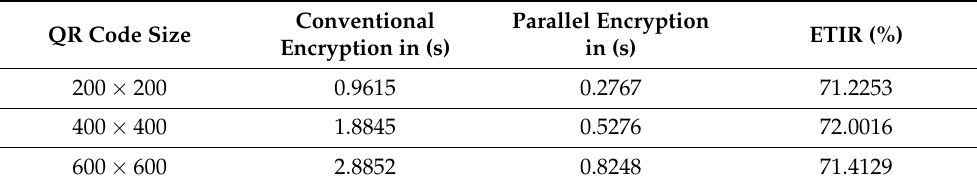
Table 3. Comparison in terms of execution time in seconds (s) between the conventional and parallel encryption of QR codes.